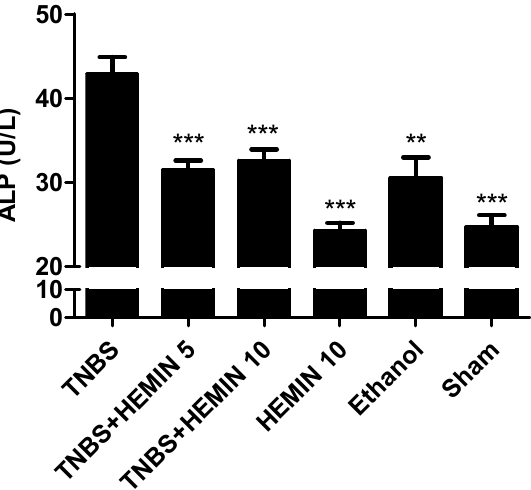
Figure 4. Effect of hemin treatment on ALP concentration in the IBD. Legend: One-way ANOVA for multiple comparisons and Tukey’s post hoc test. ** p < 0.01; *** p < 0.001; compared with TNBS group.